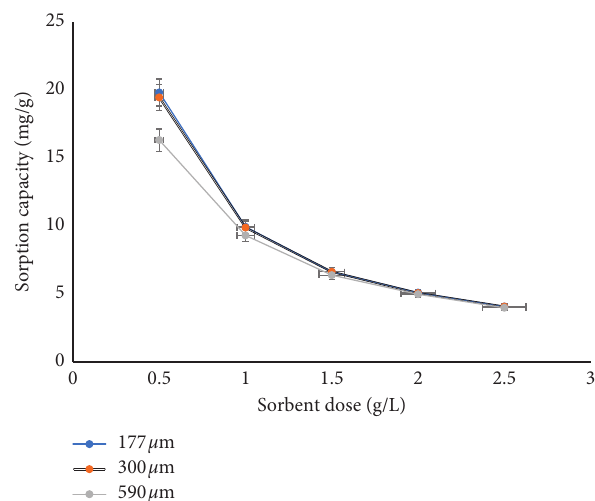
Figure 11: MB sorption capacity as a function of particle size.